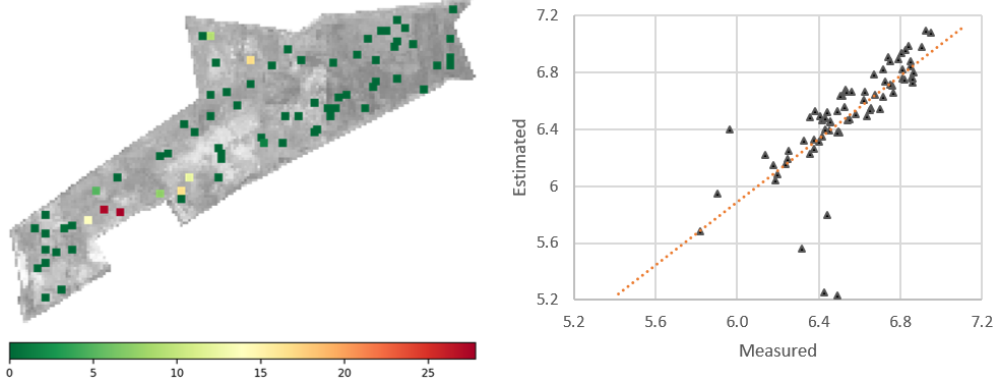
Figure 7. Validation of pH value prediction model with its error as a map and scatter plot on Stadtfeld field [46] from the second sampling